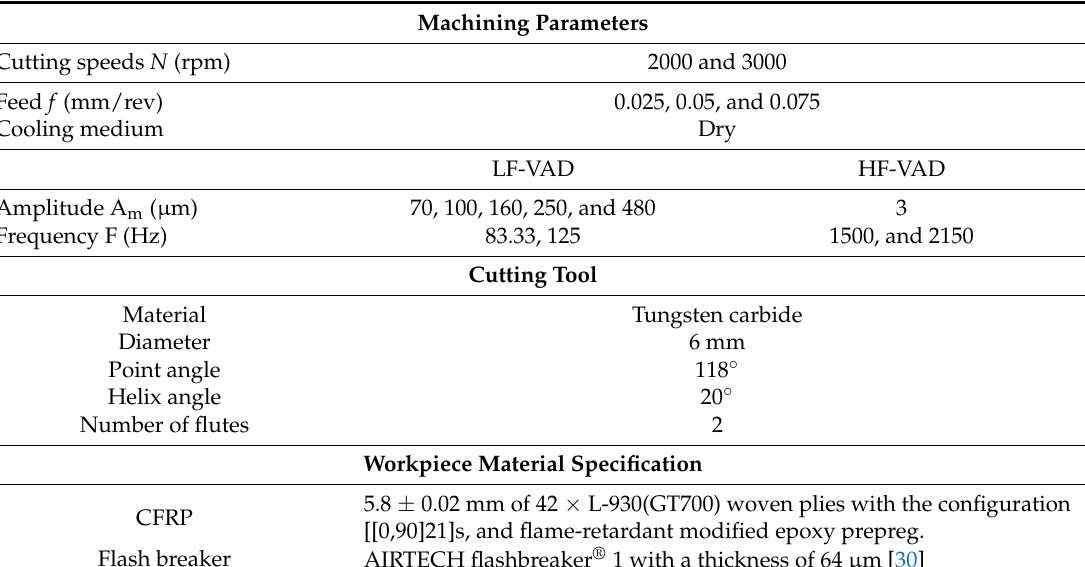
Table 1. Applied cutting conditions, cutting tool, and workpiece material.